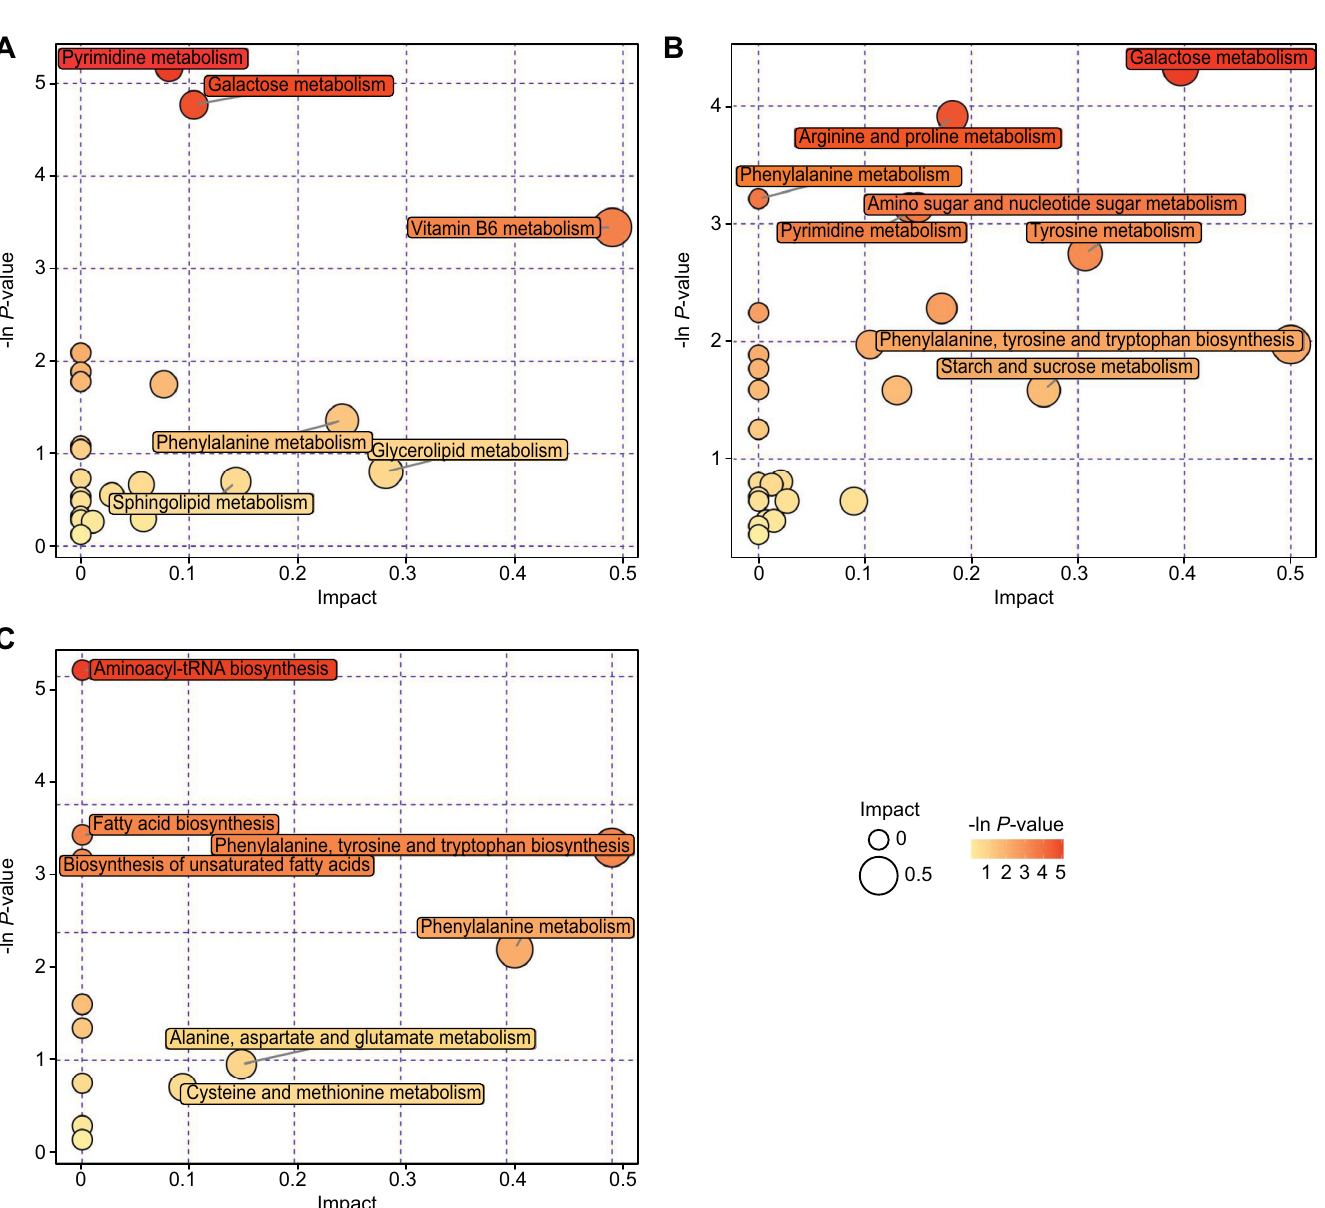
PLOS ONE | https://doi.org/10.1371/journal.pone.0208031 November28,